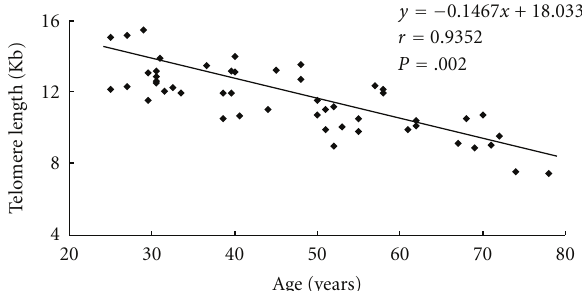
Figure 1: Telomere length of healthy people. Telomere lengths of these healthy persons are measured with real-time PCR in blood cells. From 25-year old person to 78 years, the telomere length becomes shorter during